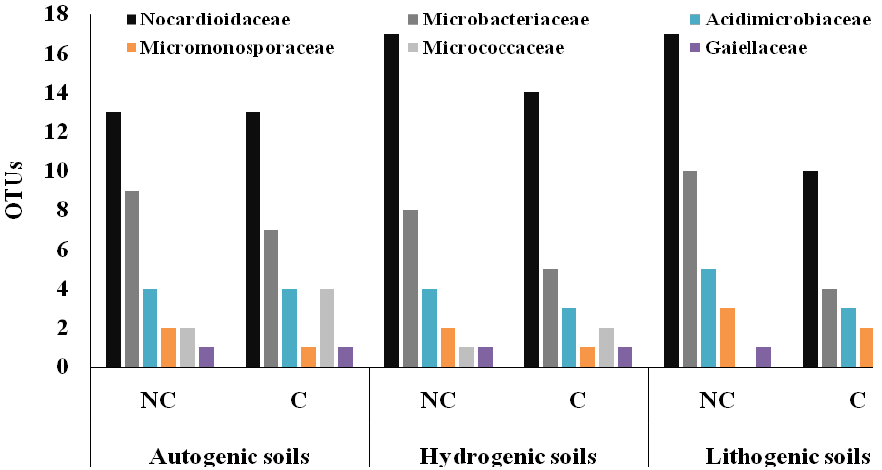
Figure 3. Relative abundance of six dominant families of Actinobacteriaacross all soil samples (NC– non-cultivated soil; C–cultivated soil) classified according to soil formation processes (autogenic, hydrogenic, and lithogenic).